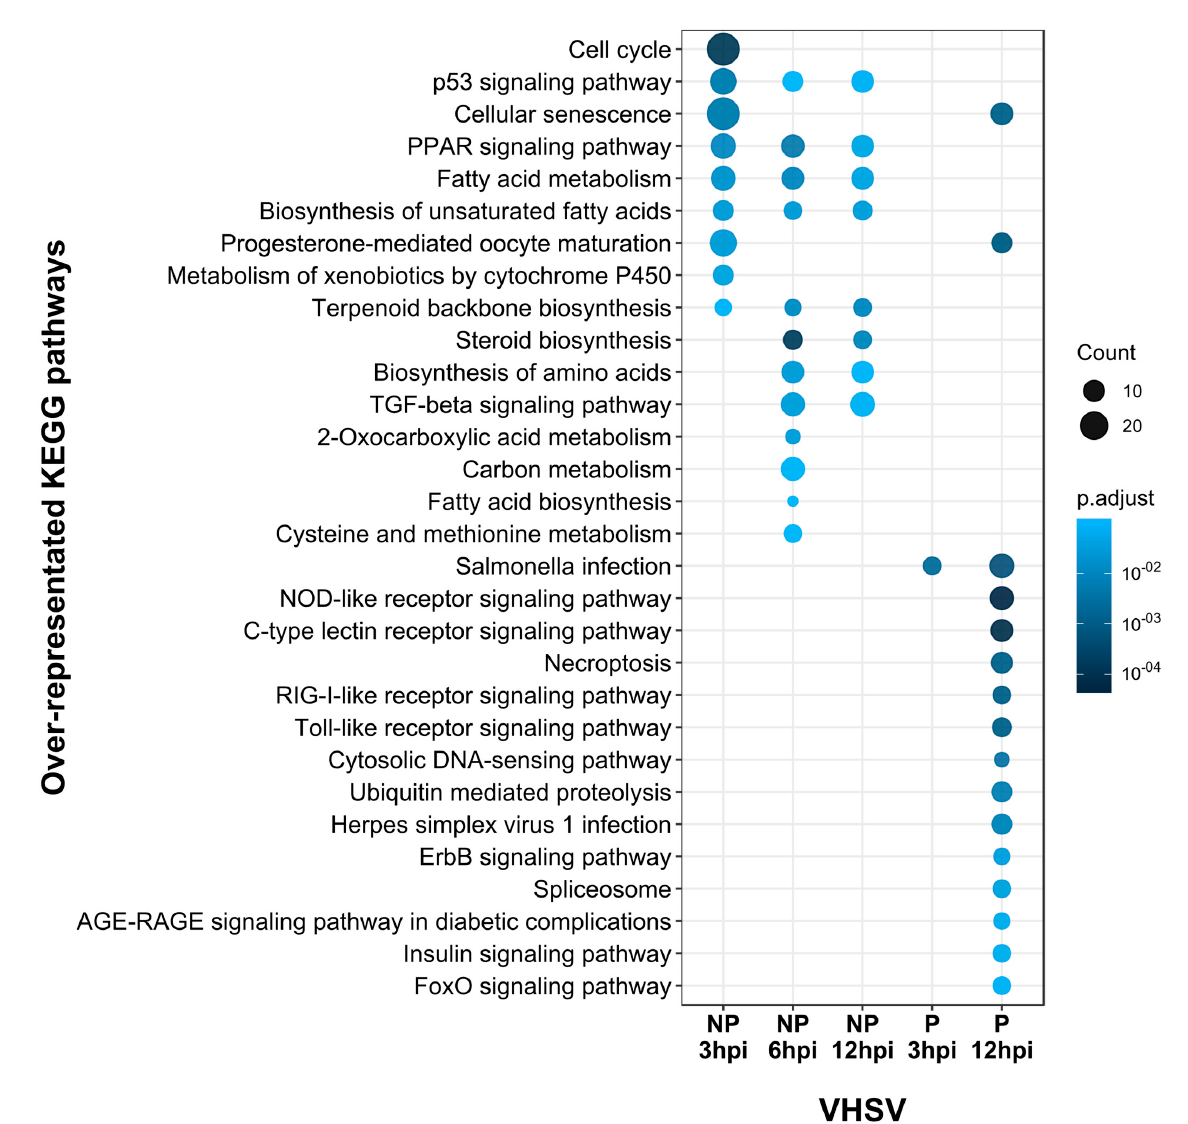
Figure 4. Dot plot of enriched Kyoto Encyclopedia of Genes and Genomes (KEGG) pathways for the non-pathogenic (NP) 1p49 and pathogenic (P) J167 viral haemorrhagic septicaemia virus (VHSV) isolates at 3, 6, and 12 h post-inoculation (hpi), based on lists of differentially expressed genes ( p < 0.05 and fold-change ≥ 2) using zebrafish orthologs of rainbow trout transcripts. KEGG pathway over-representation analysis was performed using enrichKEGG (Benjamini–Hochberg correction, FDR < 0.1) and the KEGG terms of all zebrafish orthologs in the dataset as background (universe). The size and colour of each dot represent the number of genes and adjusted p value (Benjamini–Hochberg correction; FDR < 0.1), respectively.